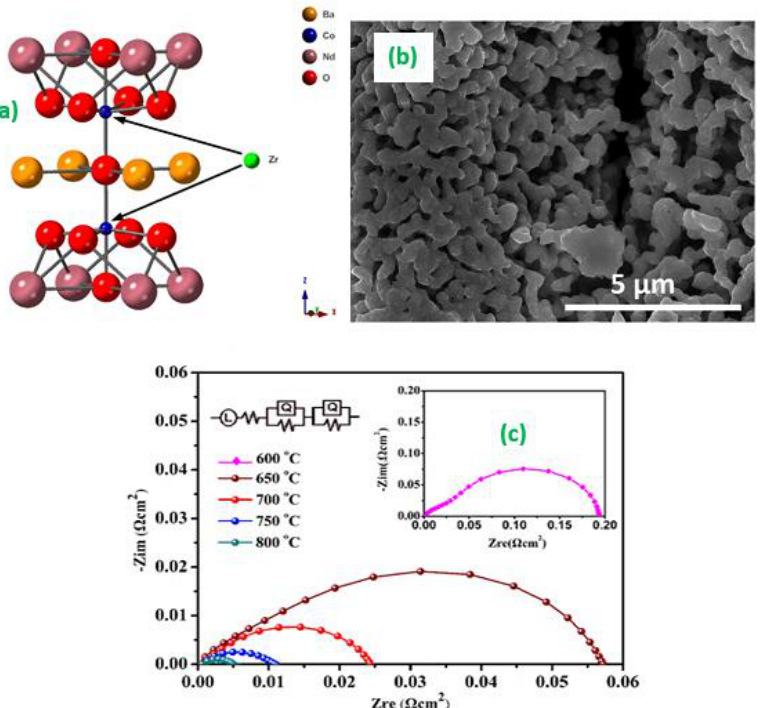
Figure 7. ( a ) crystal structure, and ( b ) SEM images of the microstructure for NdBaCo 1.95 Zr 0.05 O 5+δ and ( c ) Typical impedance spectra of symmetric cells measured under an open-circuit condition. Copyright 2019 by the American Chemical Society [59].